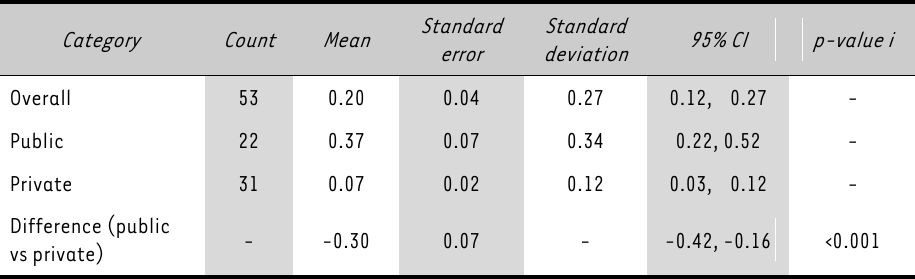
TABLE 8: Proportion of internal audit service hours provided by external service providers versus external and internal service providers